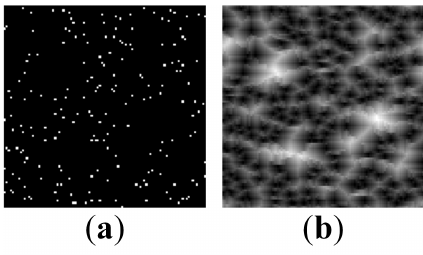
Figure 3. Initial cell state conditions ( a ) and the resulting pattern after 20 iterations ( b ). Parameter ν is set to 0 . 5 ; τ = 20